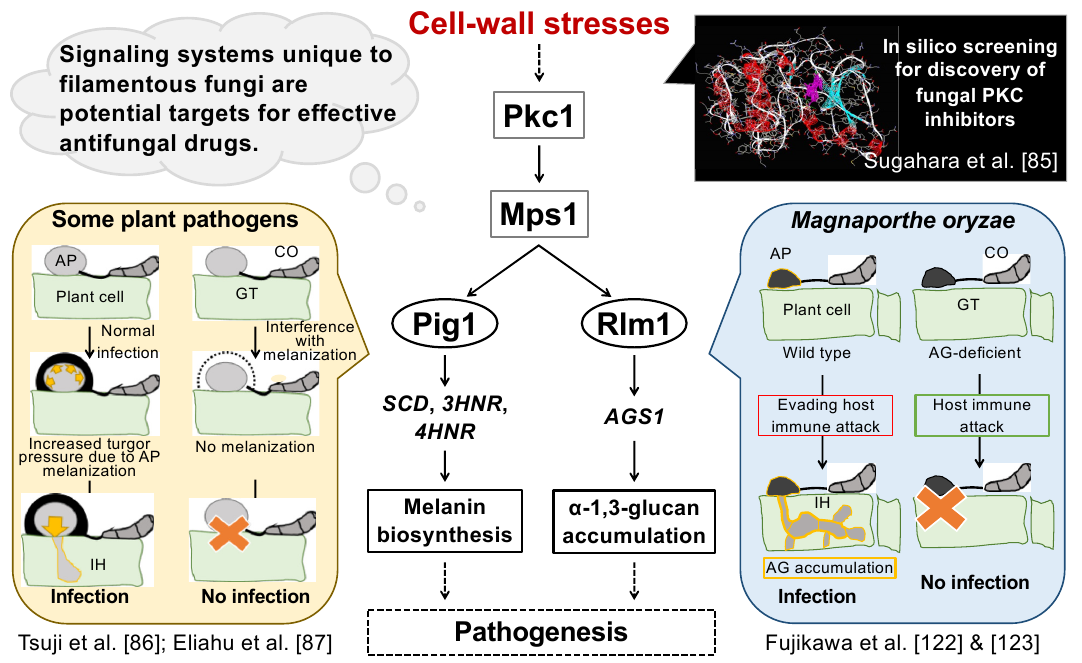
Figure 1. Diagram of drug development to target the CWI signaling pathway in filamentous fungi. In M. oryzae , Pkc1 is a protein kinase C, Mps1 is a MAP kinase, and Pig1 and Rlm1 are transcription factors. SCD (encoding scytalone dehydratase), 3HNR (trihydroxy-naphthalene reductase), and 4HNR (1,3,6,8-tetrahydroxy-naphthalene reductase) are involved in the biosynthesis of 1,8-dihy- droxynaphthalene (DHN) melanin in several plant pathogens, including M. oryzae. AGS1 encodes α -1,3-glucan synthase. Abbreviations: AP, appressorium; GT, germ tube; CO, conidium; IH, inva- sive hyphae; AG, α -1,3-glucan.